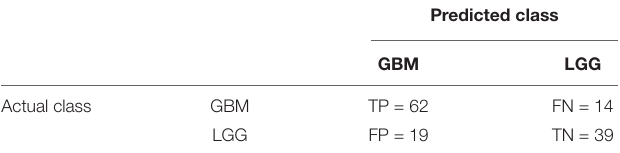
TABLE 4 | Confusion matrix for glioma grading